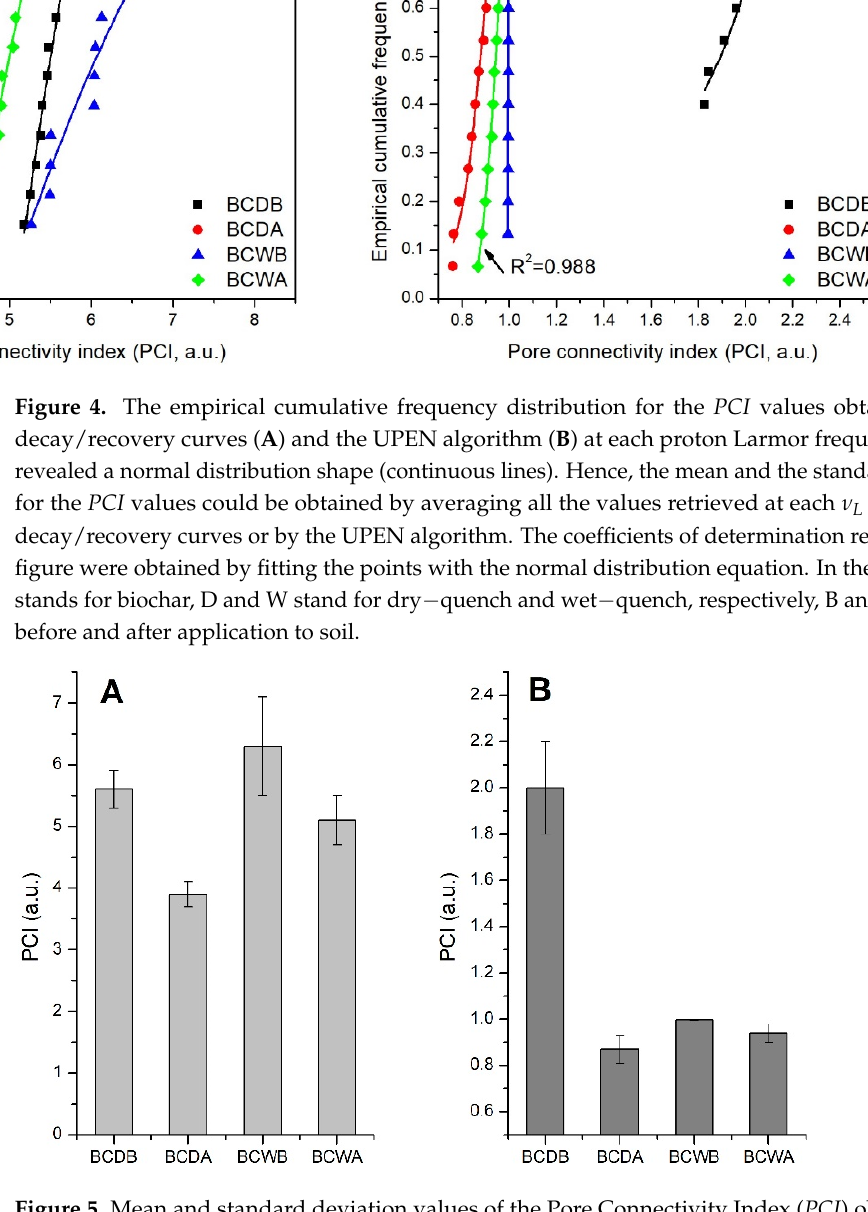
Figure 5. Mean and standard deviation values of the Pore Connectivity Index ( PCI ) obtained from the decay/recovery curves ( A ) and UPEN algorithm ( B ). The values were obtained by averaging the PCI values at each ν L . The acronyms on the horizontal axes must be interpreted as follows: BC stands for biochar, D and W stand for dry − quench and wet − quench, respectively, B and A stand for before and after application to